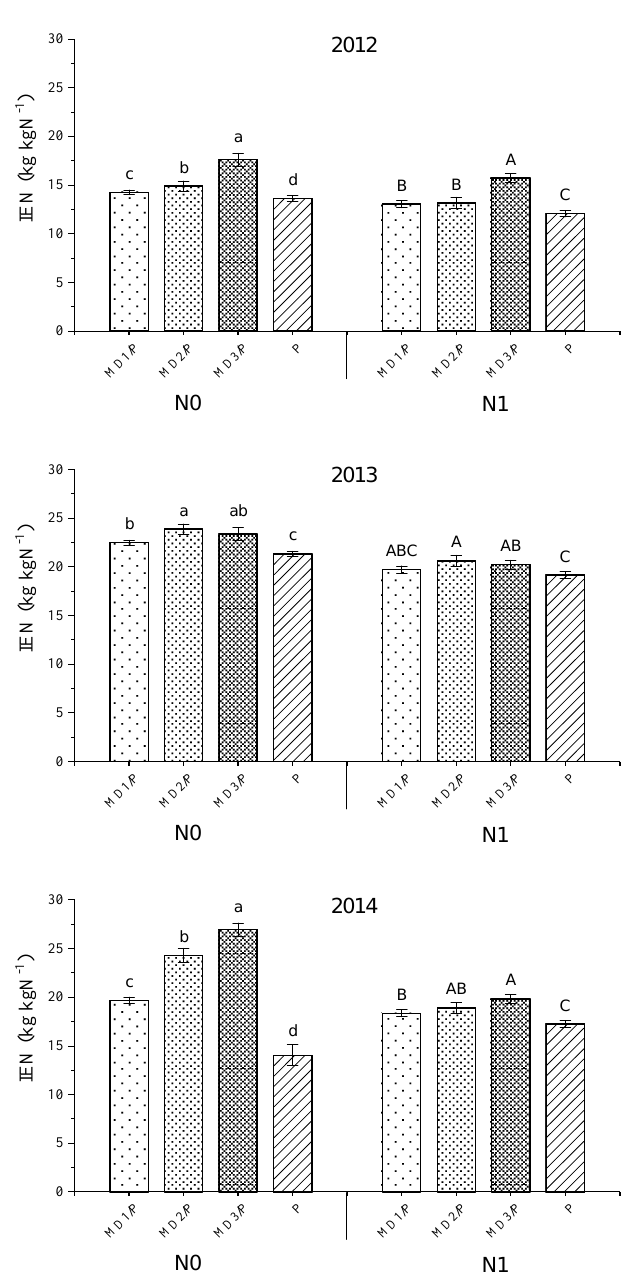
Figure 3. Internal efficiency of nitrogen (IEN) of pea for pea monoculture (P) and maize/pea intercropping (MD1/P, MD2/P, and MD3/P for different intercropped maize densities) in the Hexi Corridor of northwestern China from 2012 to 2014. Crops were either unfertilized (N0) or received 135 kg N ha − 1 in the co ‐ growth period of pea and maize (N1). Details of the maize/pea intercropping treatments are provided in Table 1. Within a given level of fertilization, different letters indicate treatment means that are significantly different at p ≤ 0.05 according to Fisher’s protected LSD test. Error bars denote the standard error of the mean ( n = 3).